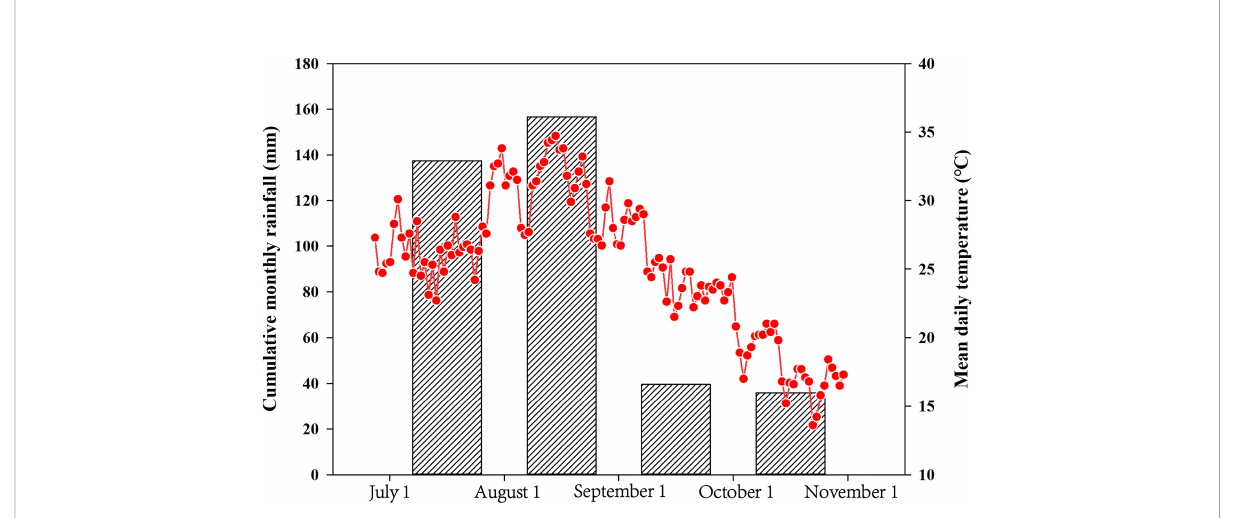
FIGURE 1 Average daily temperatures and cumulative monthly rainfall during the waxy maize-growing seasons from July1 to October